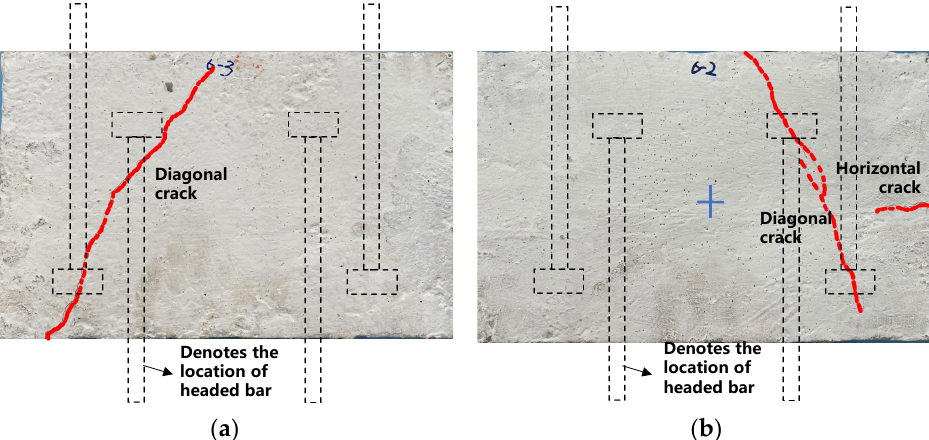
Figure 8. Crack development at peak load ( a ) Diagonal crack (specimen 6-3); ( b ) Horizontal crack (specimen 6-2).